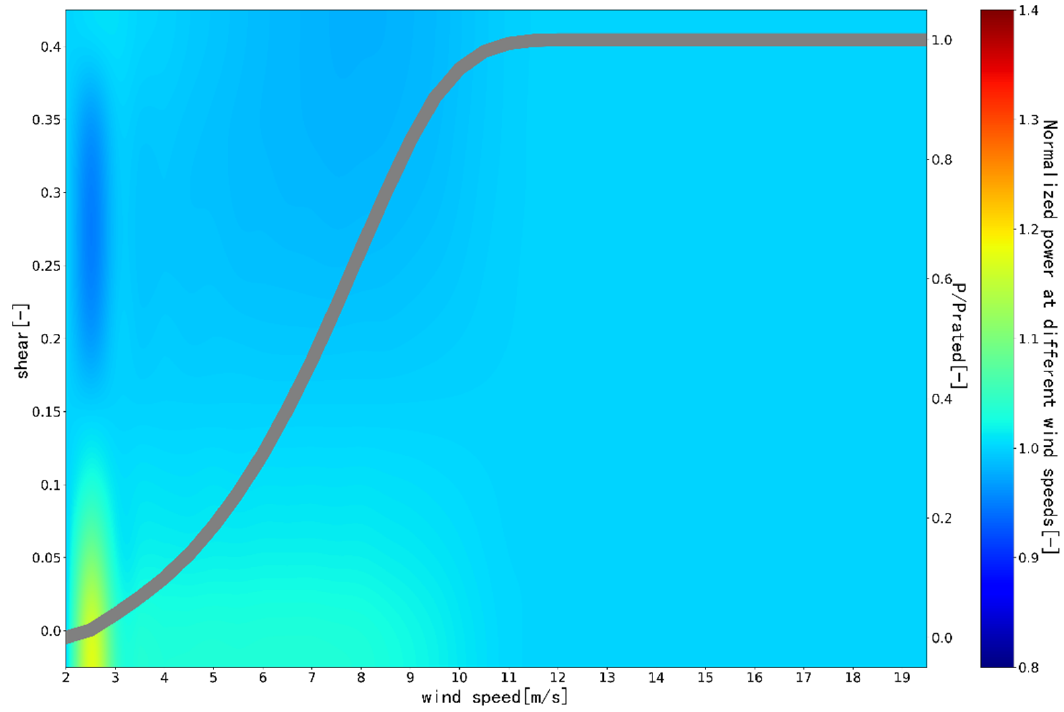
Figure 2. The effect of wind shear on WTG OP (color axis = normalized power at different wind speeds).